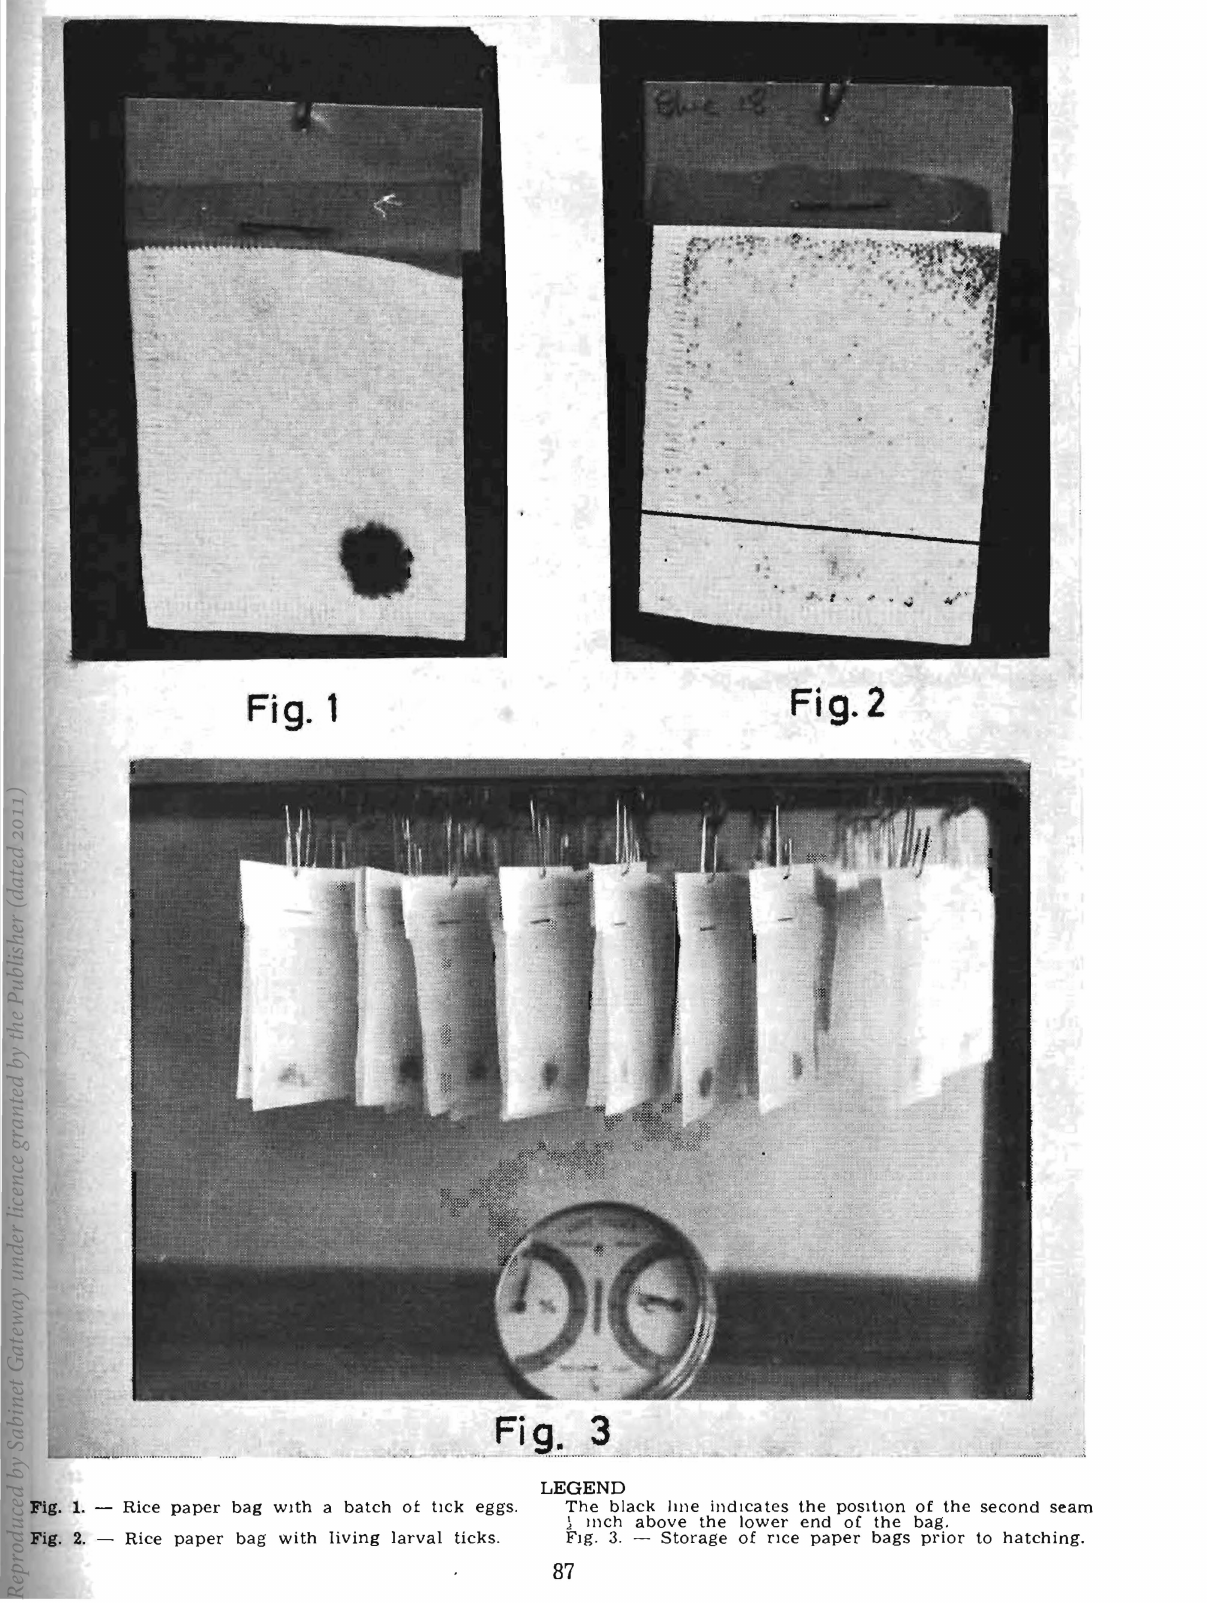
Rice paper bag with a batch ot tick eggs. Rice paper bag with living larval ticks. p R e